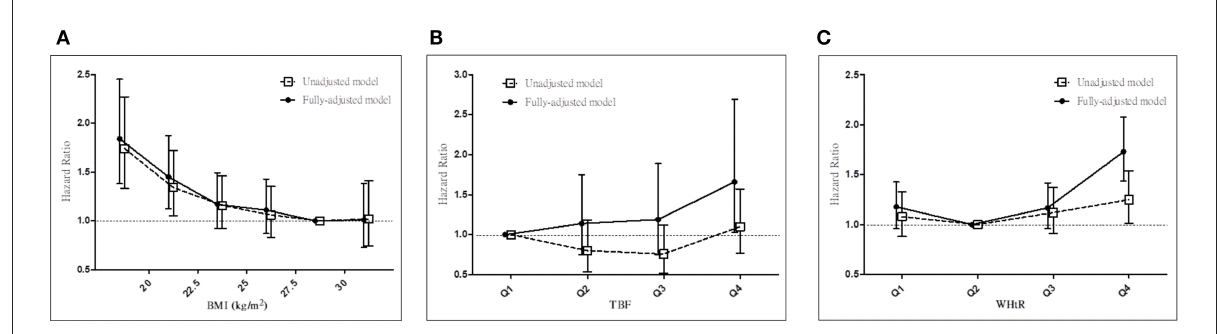
FIGURE1 Associations between anthropometric markers and all-cause mortality in all patients with stage 3–5 CKD. Hazard ratios for all-cause mortality based on (A) BMI, (B) total body fat percentage, and (C) WHtR before and after adjustments. CKD, chronic kidney disease; BMI, body mass index; WHtR, waist-to-height ratio.